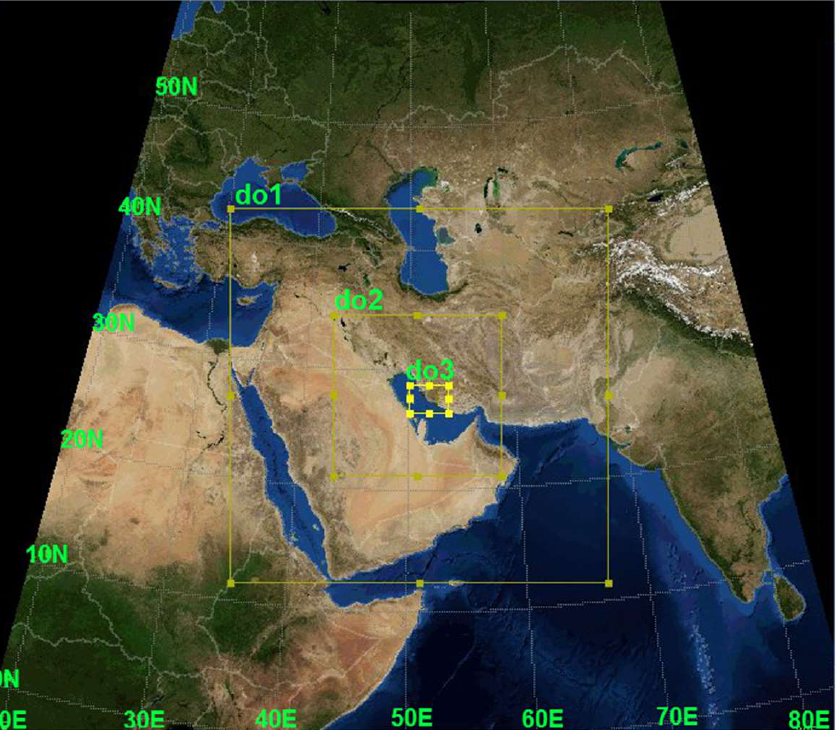
Figure 2. The WRF model offers several solvers of the physical and chemical equations, enabling optimization of the model for a specific weather phenomenon and a study area. For microphysics parameterization, radiation (shortwave/longwave), land surface, surface layer, PBL, and cumulus formation the Thompson six-class microphysics scheme, Dud- hia/RRTM, the Noah Land Surface Model, Monin Obokhov, YSU, and Kain-Fritsch were selected, respectively.